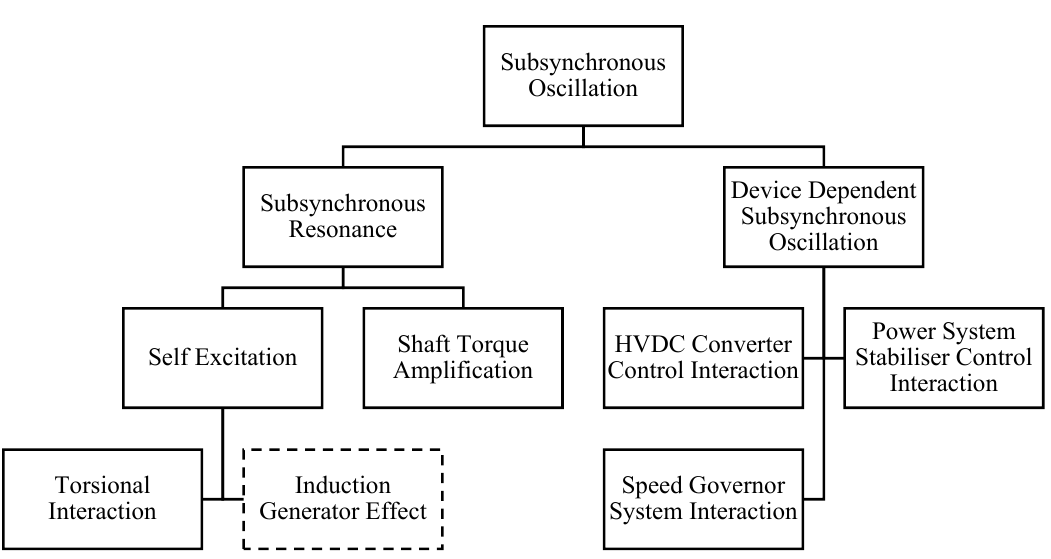
Figure 1. Current classification of subsynchronous oscillations based on [8,13]. Solid boxes represent SSO phenomena that are electromechanical in nature. Dashed boxes represent electromagnetic phenomena.